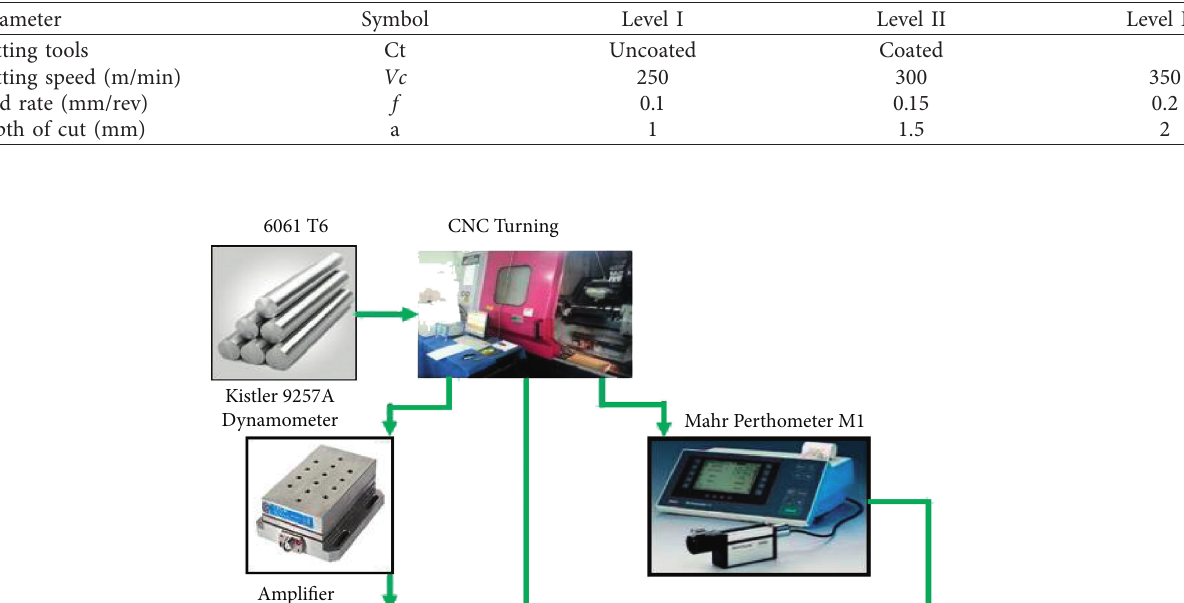
Table 3: Turning parameters and levels.